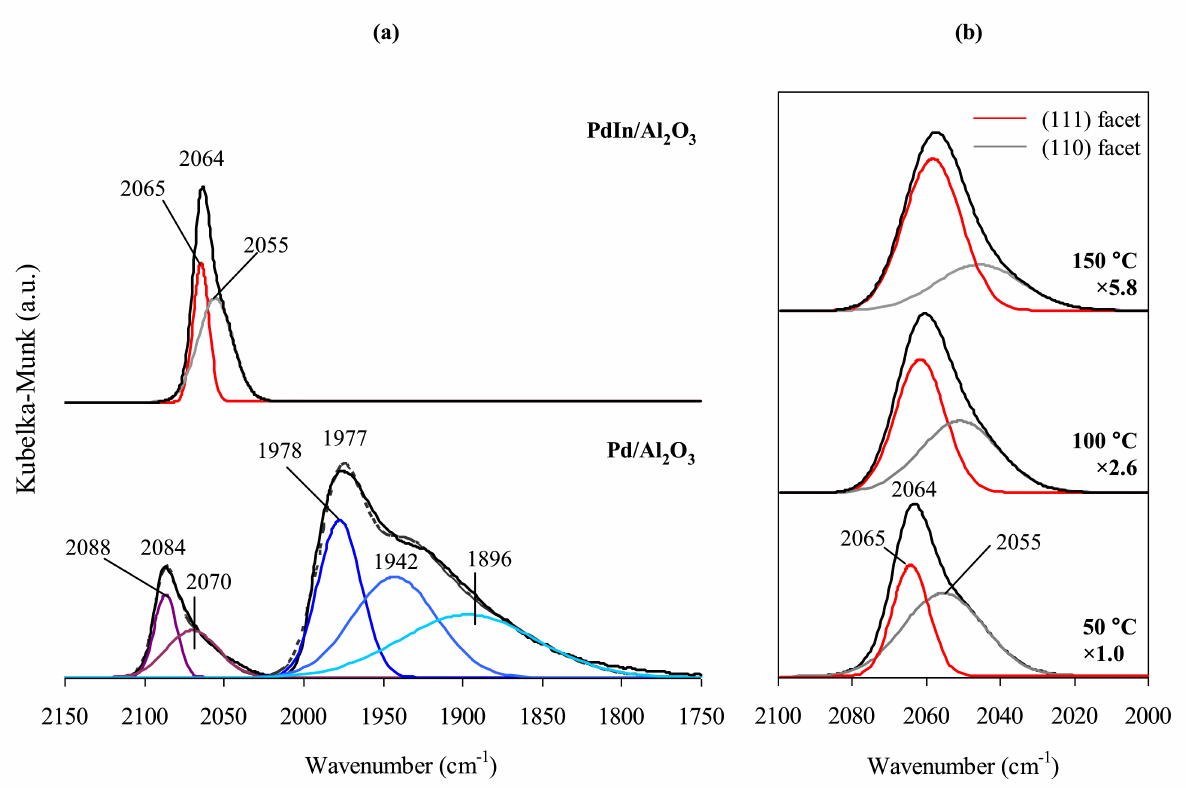
Figure 2. CO-DRIFTS data for Pd/Al 2 O 3 and PdIn/Al 2 O 3 catalysts ( a ) Deconvolution of CO − DRIFTS spectra of Pd/Al 2 O 3 and PdIn/Al 2 O 3 catalysts; ( b ) CO − DRIFTS spectra with fitted bands for PdIn/Al 2 O 3 catalyst at different